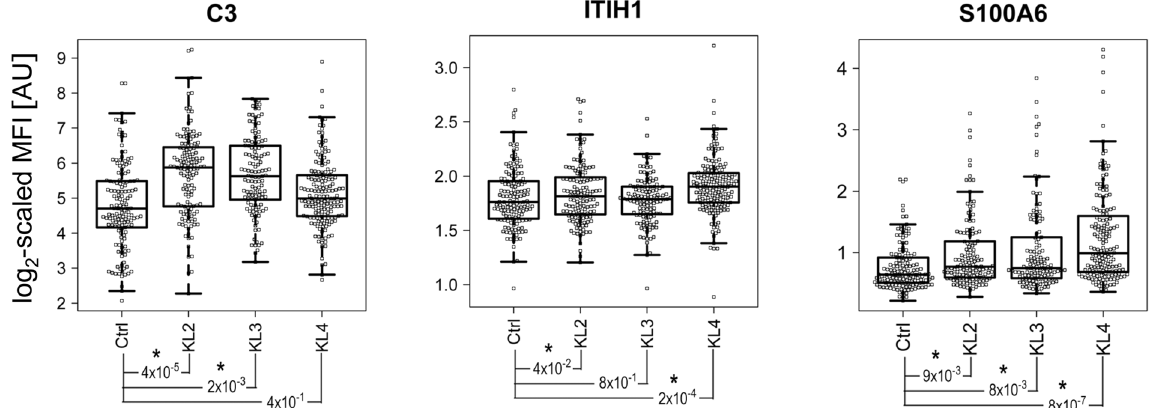
Figure 4. Box-plots showing the differential profiles of the three proteins between healthy controls and the different OA K/L groups from the two samples sets (screening and verification sets) combined. For each sample group, the box-and-whisker plot represents MFI values within lower and upper quantile (box), the median (horizontal line within box), percentiles of 5% and 95% (whiskers) and outliers (dots). Comparisons indicated with an * were statistically significant (P < 0.05).